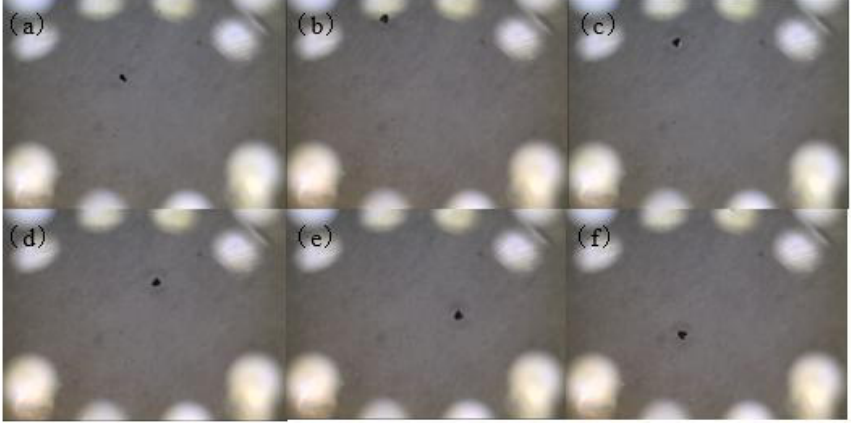
Figure 6. Captured images (every 2 s) from the clip of hollowbots actuated by external magnetic field in isopropyl alcohol. ( a ) 0 s; ( b ) 2 s; ( c ) 4 s; ( d ) 6 s; ( e ) 8 s; ( f ) 10 s.